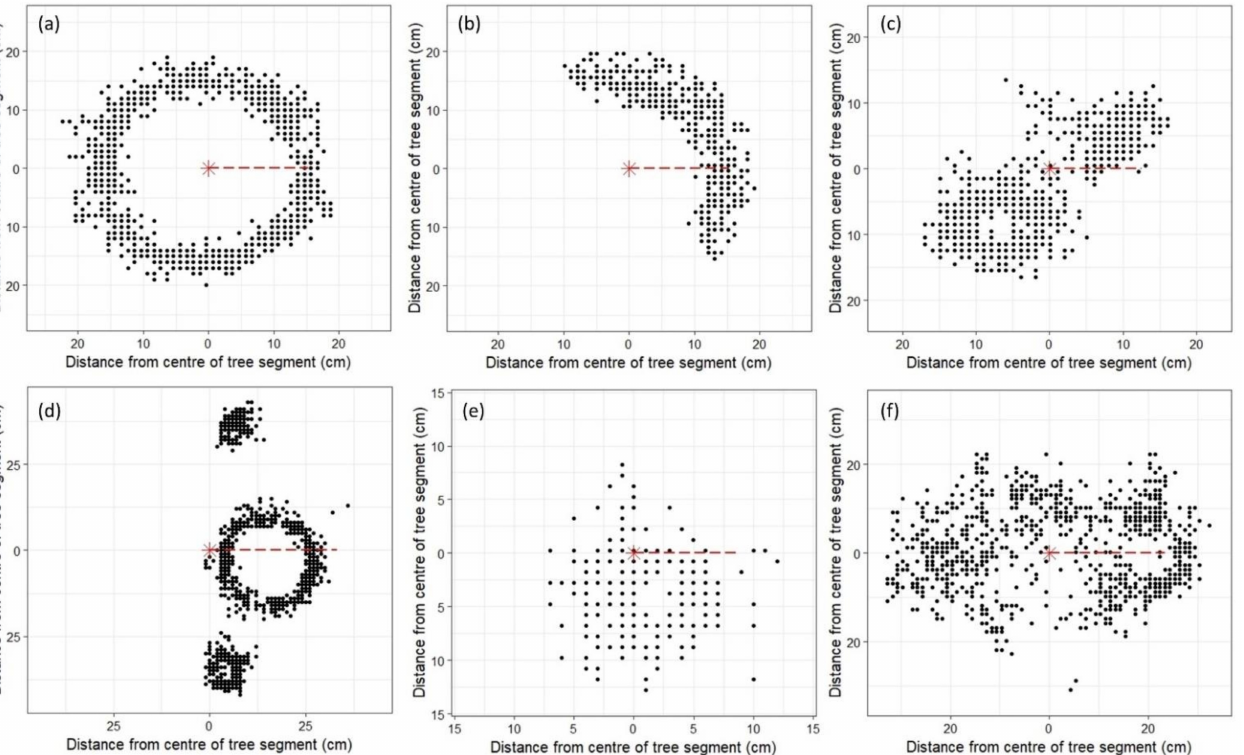
Figure 18. Stem cross-sections at DBH height, with red cross denoting estimated centre point from sphere fitting and red dashed line showing the estimated radius. Cross-sections align with profiles from Figure 7: ( a ) tree F43—clear segmentation with accurate DBH, ( b ) tree D26—stem cut in half vertically by tiling errors, ( c ) tree G4—forked tree with additional leader diverging from main stem below DBH height, ( d ) tree O40—inclusion of more than one tree as a single segment, ( e ) tree G47—considerable needle noise at DBH height and ( f ) tree T41—understorey points attached to